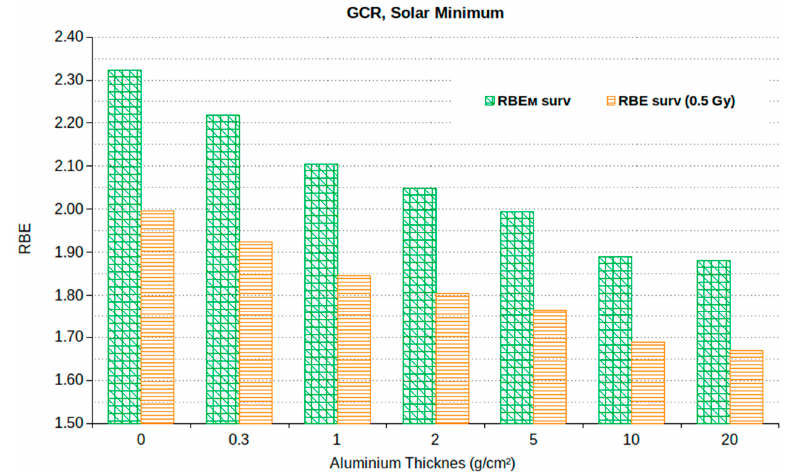
Figure 6. RBE M and RBE at 0.5 Gy for cell survival at solar minimum.